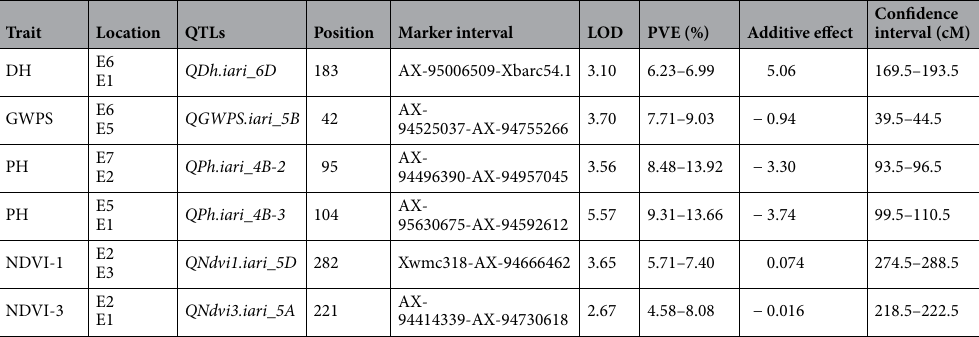
Table 3. List of stable QTLs consistently detected between different locations in BILs of HD2733/2*C306. E1-Delhi rainfed (2016–2017), E2-Delhi irrigated (2016–2017), E3-Indore restricted irrigation (2016–2017),